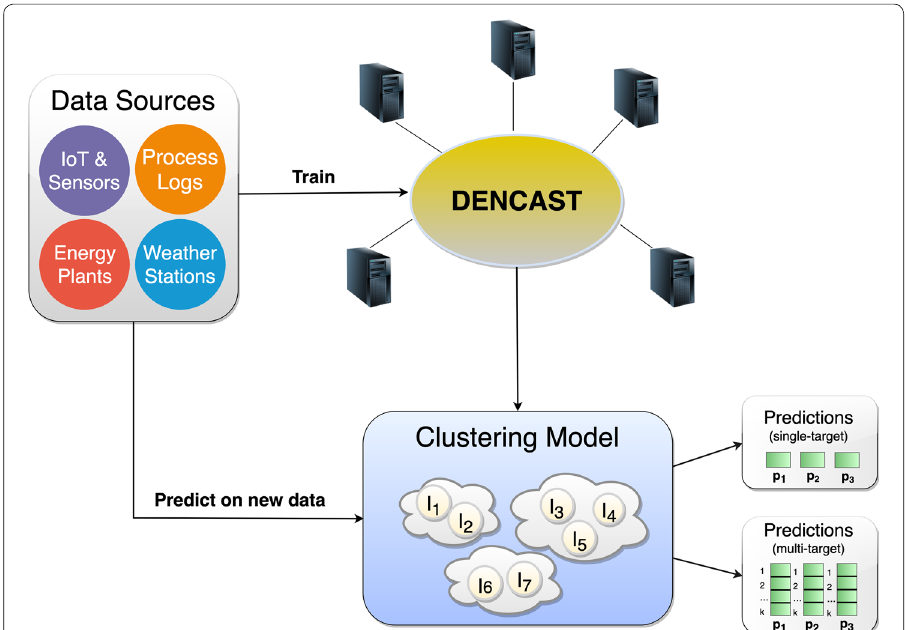
Fig. 1 Overview of the environment in which DENCAST works. In the figure, data coming from multiple sources are fed into DENCAST, which produces a clustering model that is exploited for predictive purposes on new data (single-target or multi-target regression). DENCAST runs on multiple computational nodes, in a distributed